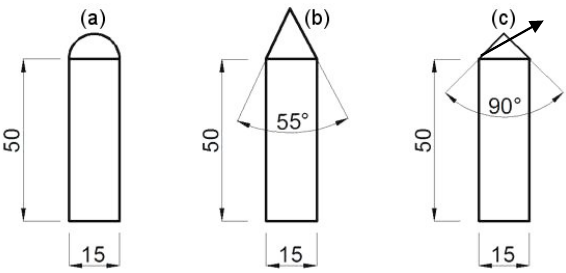
Figure 3. Geometry, shapes, and dimensions of impactors for ( a ) hemispheric, ( b ) conic 55 ◦ , ( c ) conic 90 ◦ , or 90°, or Ogive.